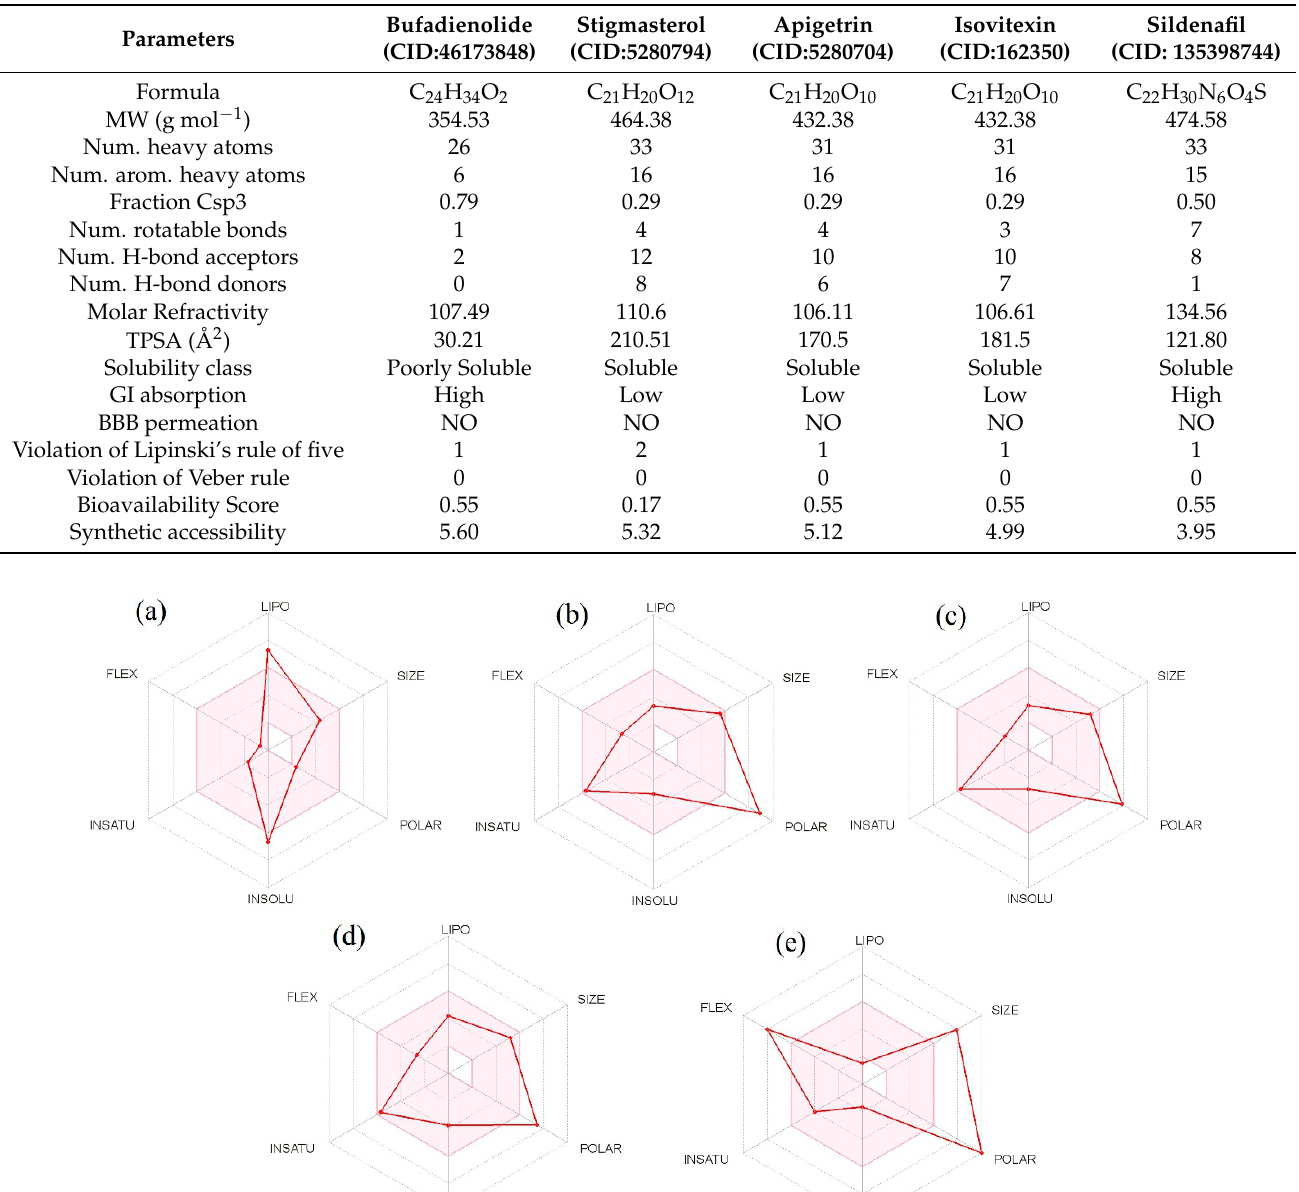
Table 3. Pharmacokinetics and physicochemical parameters of selected top binding scored bioactive molecules and the standard PDE 5 inhibitor.